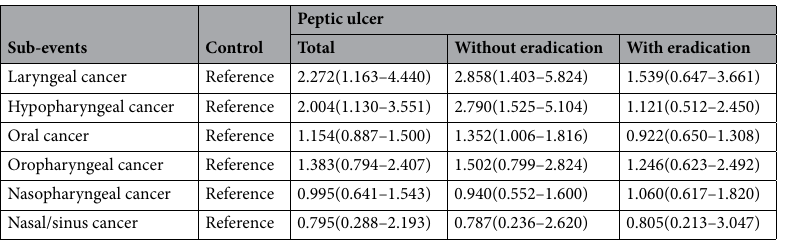
Table 3. Adjusted hazard ratio of different origin of head and neck caner (Follow up > 6